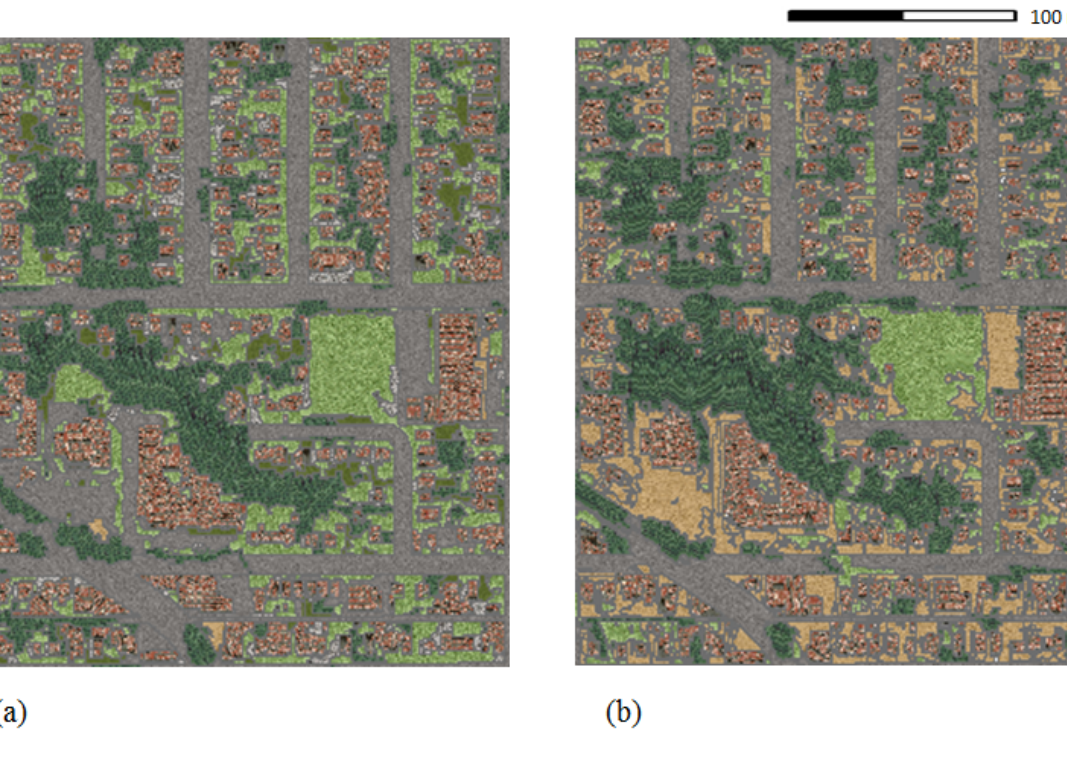
Figure 3. Example of: (a) 2002 and (b) 2009 OBIA drive classifications, where: dark green represents tree cover, light green represents grass and fields and all other colors are impervious surfaces (grey for roads and paved areas, light brown for ground and brown for buildings). This color scheme allows for a visual hierarchical aggregation to a vegetation class (tones of green) and impervious class (tones of greys and